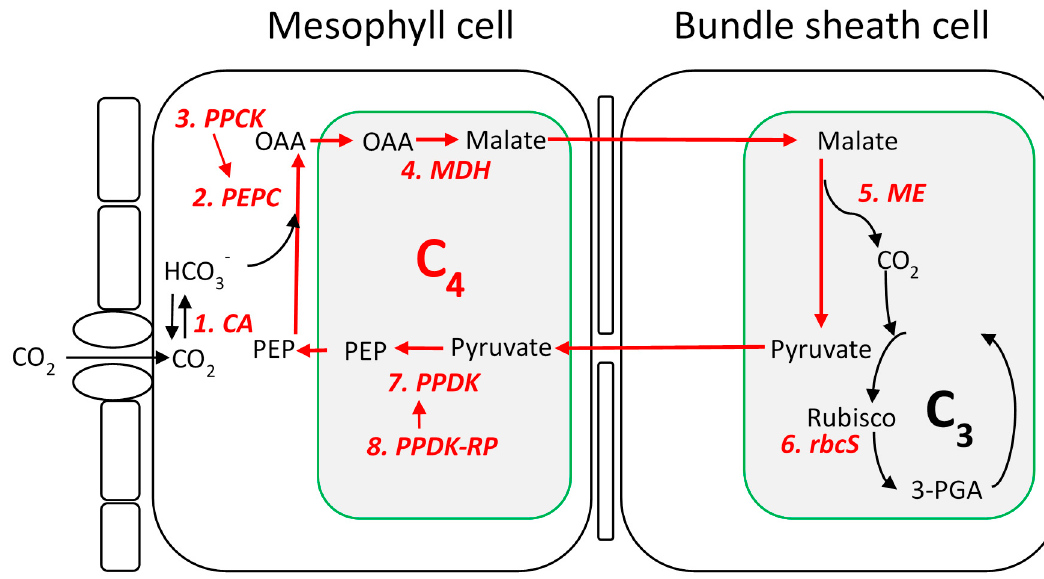
Figure 1. Diagram of the nicotinamide adenine dinucleotide phosphate ‐ malic enzyme (NADP ‐ ME) biosynthetic pathway of C 4 photosynthesis (adapted from [40] ). In the mesophyll cells, CO 2 is converted to HCO3 − catalyzed by carbonic anhydrase (CA) and fixed into the four ‐ carbon acid, oxaloacetate (OAA), by phosphoenolpyruvate carboxylase (PEPC). Phosphorylation of PEPC is carried out by PEPC kinase (PPCK). The OAA generated by PEPC is then reduced to malate by the NADP ‐ malate dehydrogenase (NADP ‐ MDH) or trans ‐ aminated to aspartate. The resultant C 4 acids, malate and aspartate, are transported to the bundle sheath and then decarboxylated in the vicinity of Rubisco to release CO 2 and pyruvate. Pyruvate is transported back to mesophyll cells to regenerate PEP by pyruvate orthophosphate dikinase (PPDK), while CO 2 enters the Calvin–Benson–Bassham cycle and is fixed by ribulose ‐ 1,5 ‐ bisphosphate carboxylase (Rubisco). Activation and inactivation of PPDK is catalyzed by PPDK regulatory protein (PPDK ‐ RP).